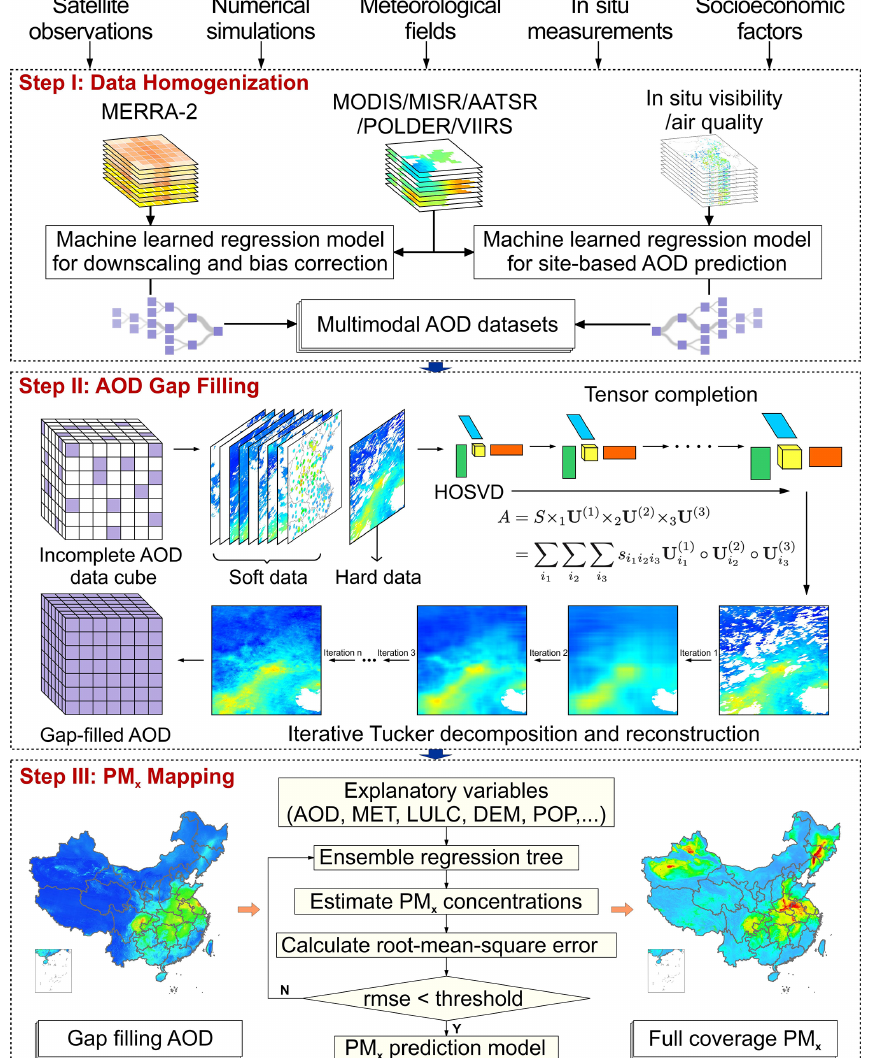
Figure 1. Flowchart of the proposed big data analytics framework for generating the long-term gap-free high-resolution air pollutant concen- tration dataset (LGHAP), taking aerosol optical depth (AOD) and PM x (PM 2 . 5 and PM 10 ) concentration in China as illustration. HOSVD is an abbreviation of high-order singular value decomposition. MET, LULC, DEM, and POP denote variables of the meteorology, land use/land cover, digit elevation model, and population,